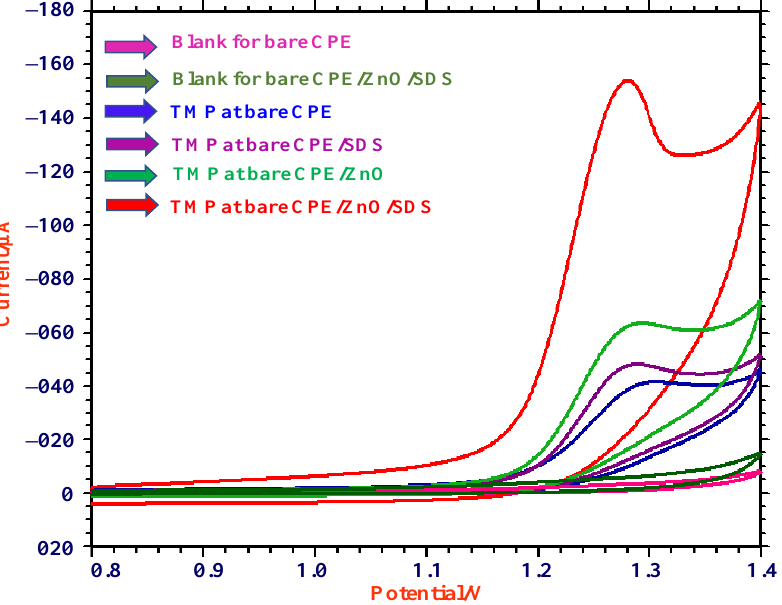
Figure 3. CV responses of 0.5 mM TMP in pH 3.0 (0.2 M PBS) at CPE, SDS/CPE, ZnO/CPE, and ZnO/SDS/CPE.